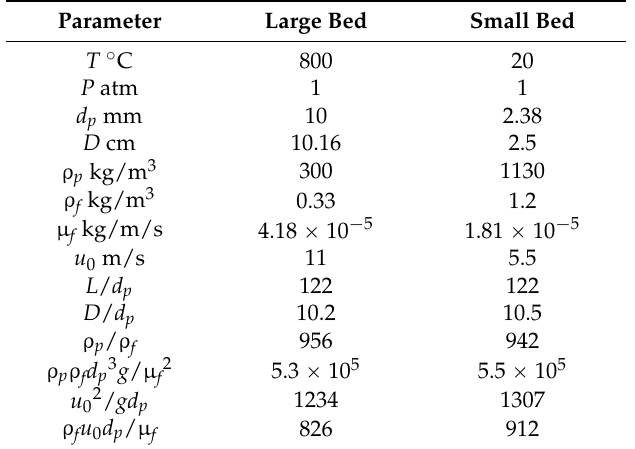
Table 1. Actual dimensionless numbers corresponding to two columns. Parameter Large